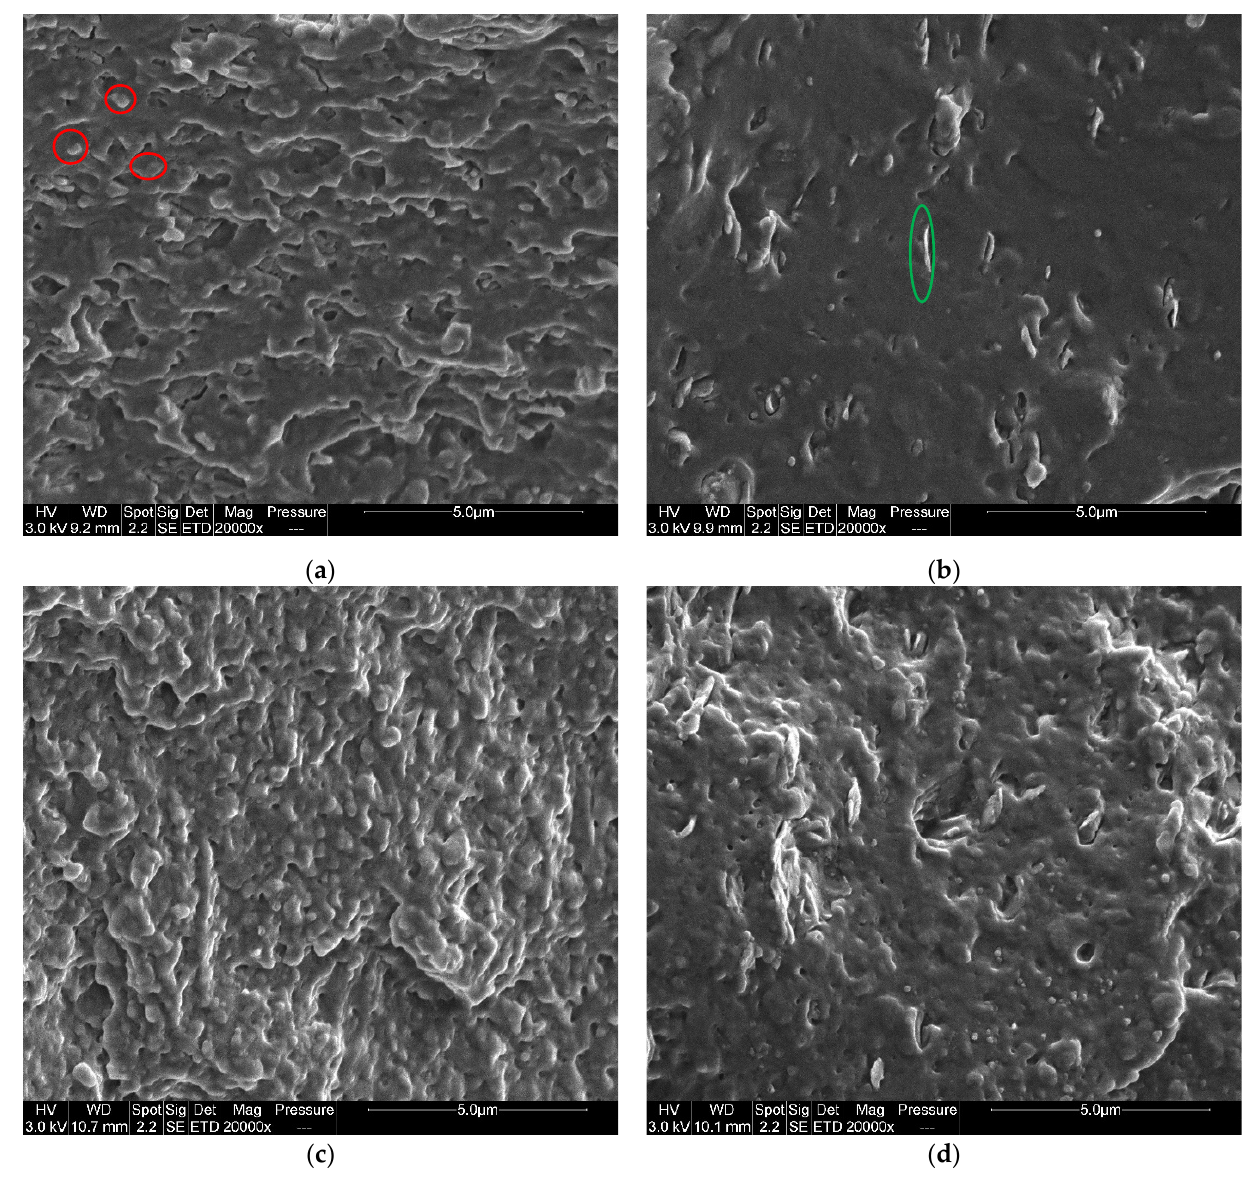
Figure 3. SEM micrographs of transversal cryo-fractured of ( a ) PLA-JD/PHB-J and ( b ) 95(PLA- JD/PHB-J)5BYK injected samples, and ( c ) PLA-JD/PHB-J-3D and ( d ) 95(PLA-JD/PHB-J)5BYK-3D printed samples.